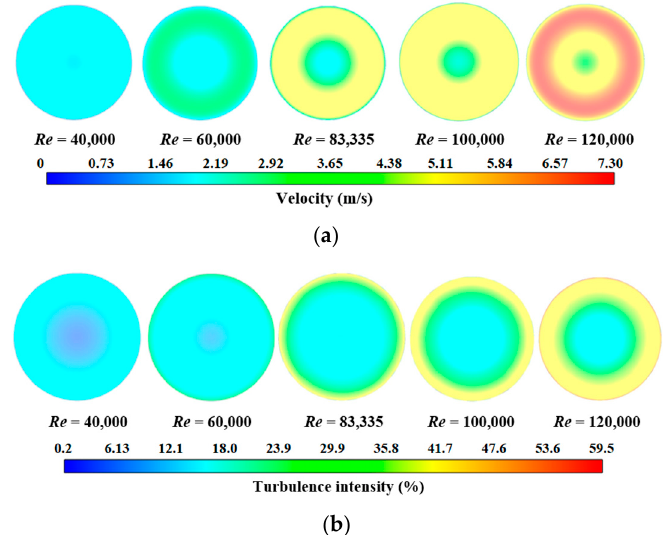
Figure 12. Flow velocity and turbulence intensity as a function of the Re number: ( a ) total velocity magnitude; ( b ) turbulence intensity.